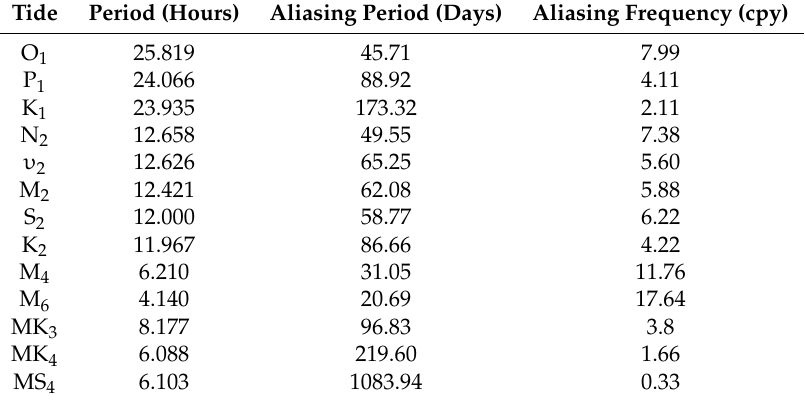
Table 1. Aliased periods (days) of major semidiurnal and diurnal tidal constituents and shallow-water tidal constituents sampled by TOPEX/Poseidon, Jason-1, and Jason-2 [19]. cpy, cycles per year.